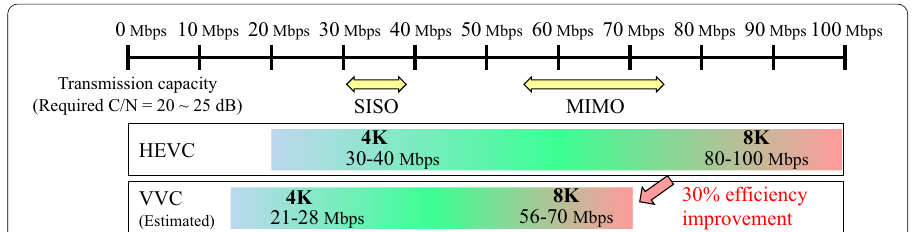
Fig. 1 Relationship between transmission capacity and maximum video bit rate for broadcasting